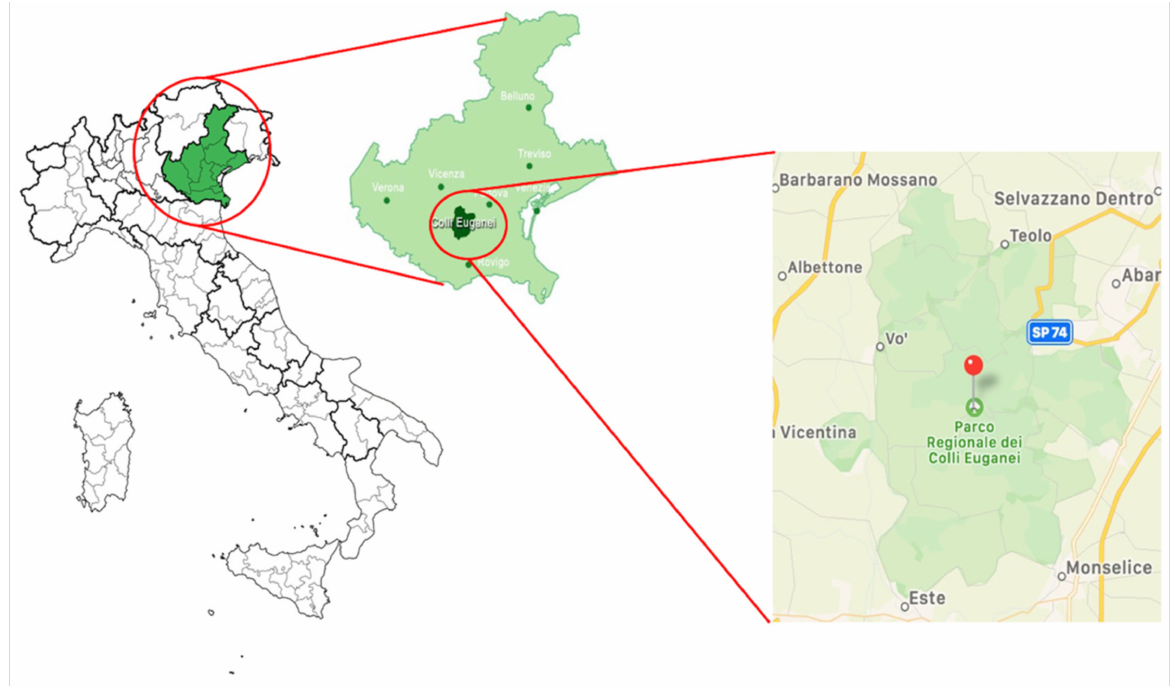
Figure 1. Euganean Hills Regional Park, northeastern